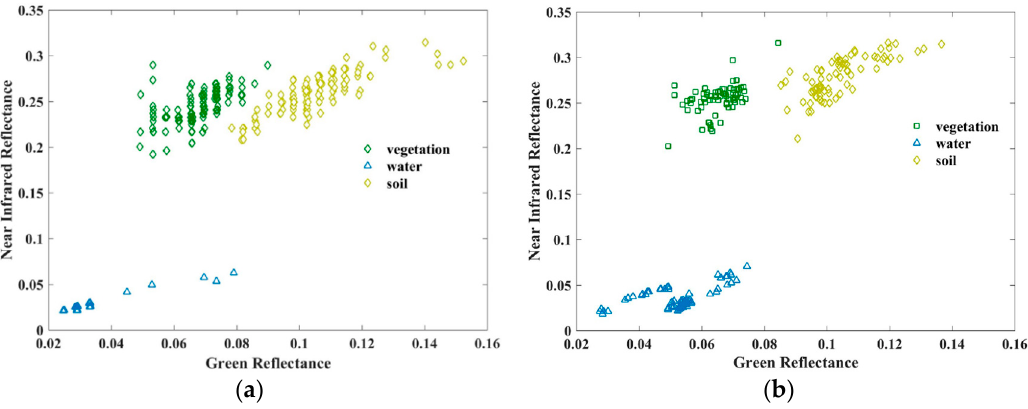
Figure 7. Scatter plot of green versus NIR spectral reflectance of an endmembers sample selected automatically from ( a ) TM and ( b ) MERIS images on 17 April 2008.